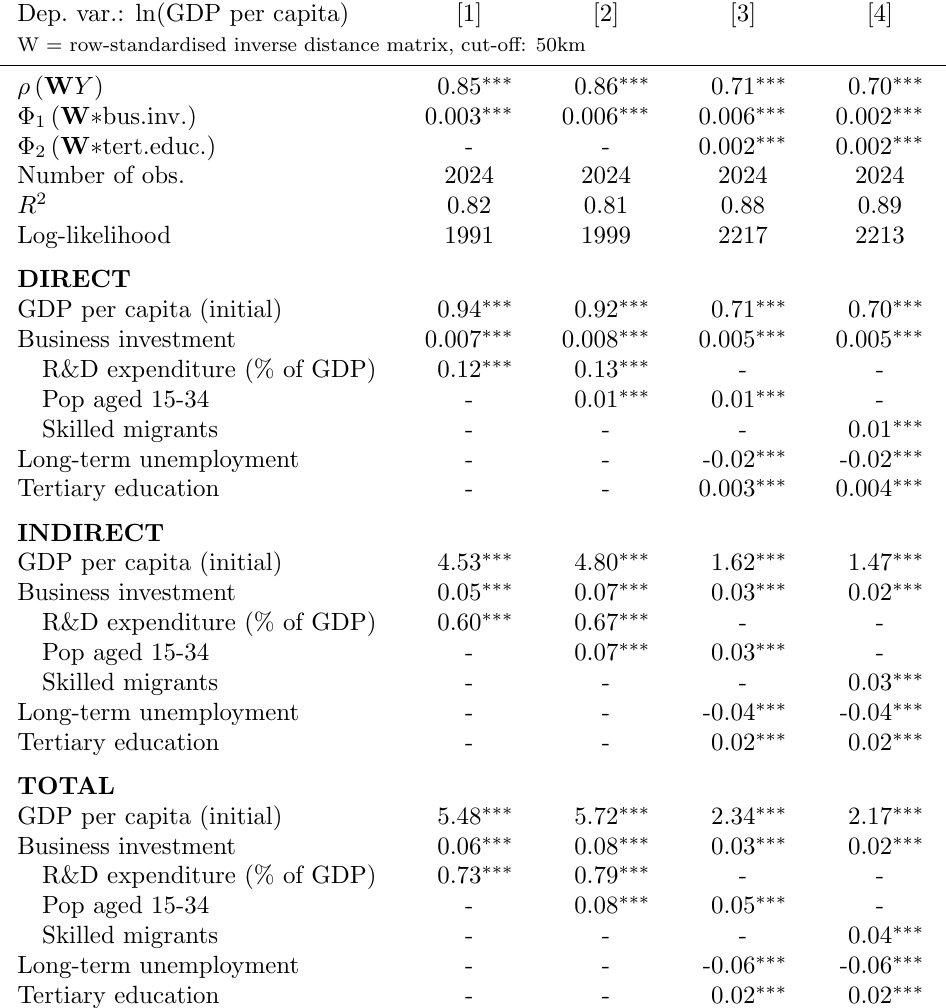
Table 2: Empirical Results – Random effect – EU sample Dep. var.: ln(GDP per capita) W = row-standardised inverse distance matrix, cut-off: